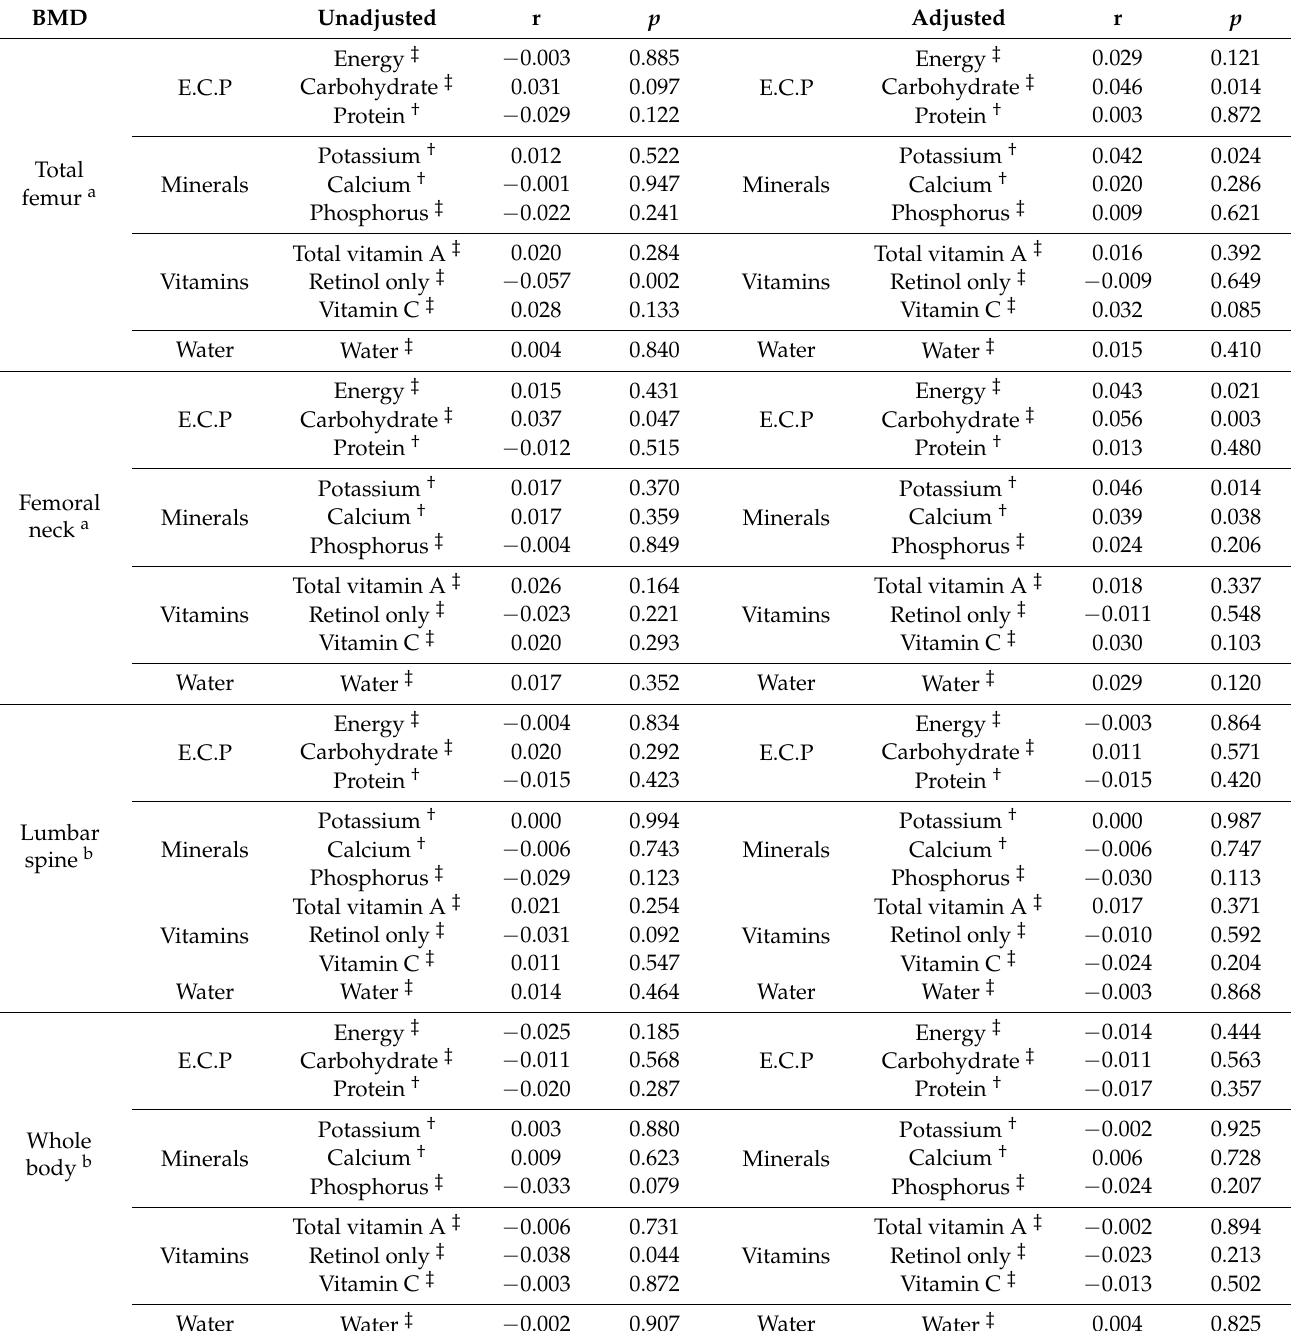
Table 9. Partial correlation coefficients between nutrient intake and bone mineral density in premenopausal